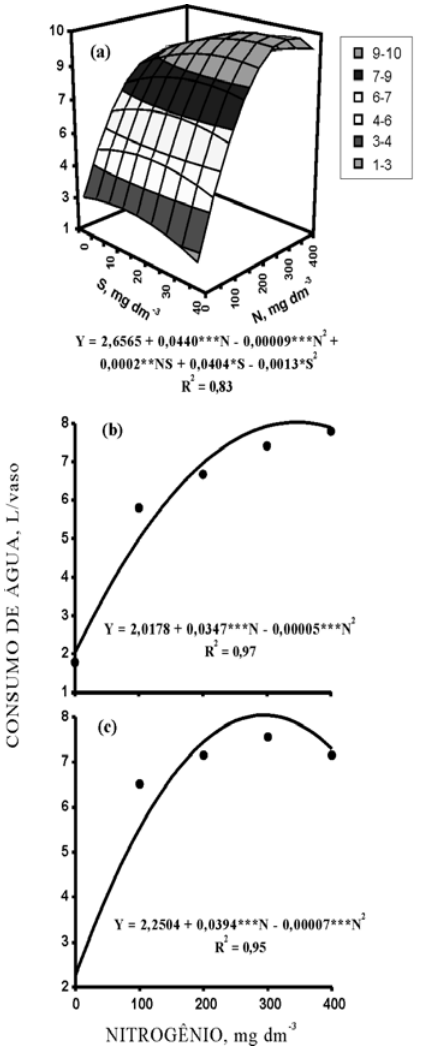
Figura 4. Consumo de água pelo capim-braquiária no primeiro crescimento (a), de acordo com a adubação com doses de nitrogênio e enxofre, e no segundo e terceiro crescimentos (b e c), considerando a adubação com doses de nitrogênio. *** ; ** e * Significativo a 0,1; 1 e 5 %,